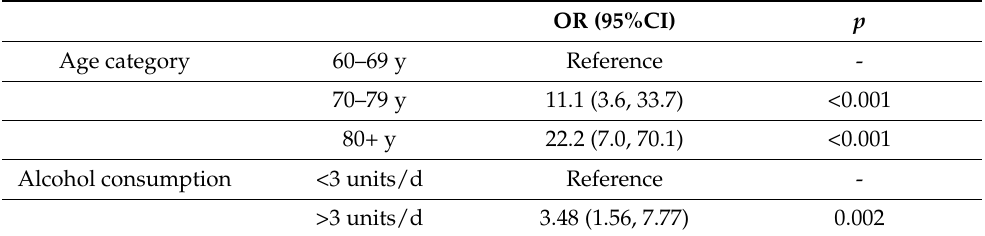
Table 2. Logistic regression model for high HF-FRAX calculated with BMD (probabilities ≥ 3%) in association with age category and alcohol